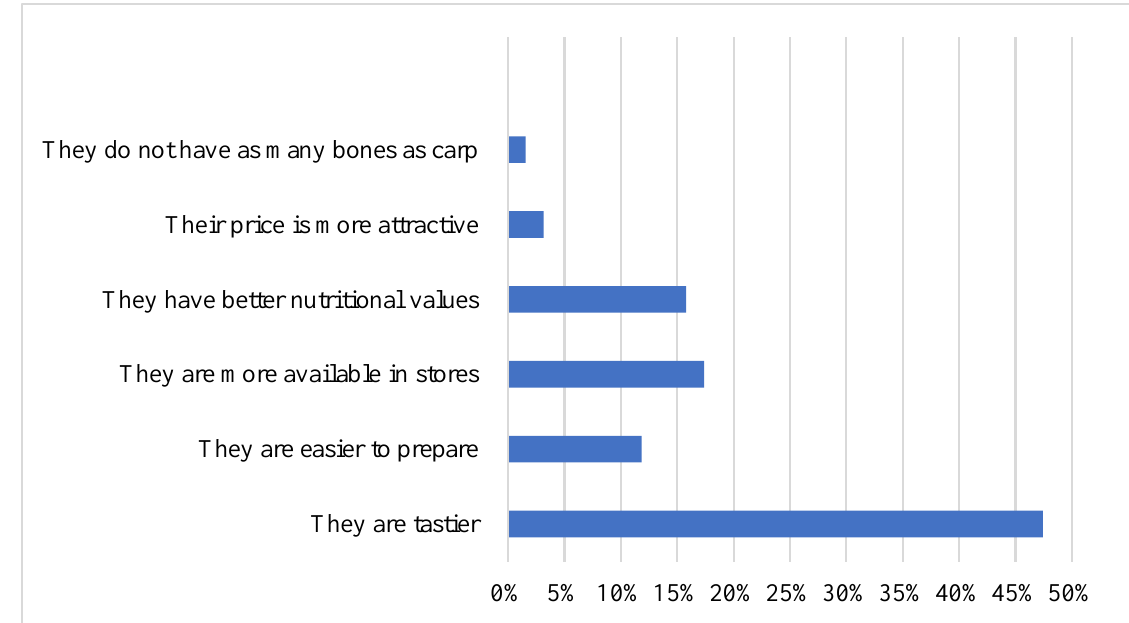
Figure 9. The importance of the origin of the purchased carp. Source: own elaboration based on data of [43]. When it comes to the form in which young consumers buy carp the most, nearly 60% declared that the most popular type of carp is fresh fish, most often found as a whole carcass with a head and scales, which must be trimmed and self-prepared. About 28% of the respondents choose a carp fillet, carcass or bells, which are much easier to prepare, but usually belong to the more expensive forms in which it is sold. The least popular are smoked carp, 4%, and carp preserves, 2%, which are, however, extremely rarely available on the market, as shown in Figure 10.